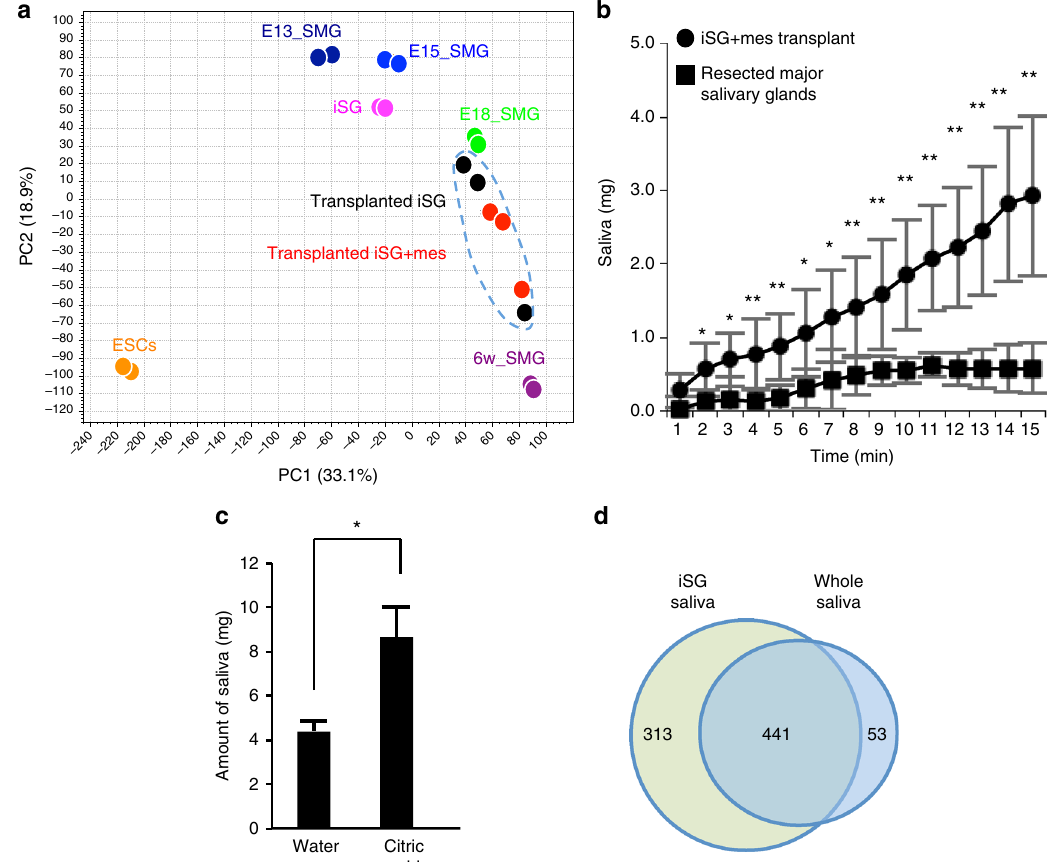
Fig. 5 Gene expression pro fi le and functional analysis of the transplanted iSG. a Principal component analysis based on RNA-seq. The data are shown for iSGs on d23, transplanted iSGs, transplanted iSG with mesenchyme, ESCs, SMG at E13.5, E15.5, E18.5, and 6 weeks. The blue circle outline indicates transplanted iSGs with or without mesenchyme. b Time-course of the amount of saliva secretion in major salivary glands-defective mice (square) and combined iSG transplanted major salivary glands-defective mice (circle), every 1 min for 15 min after intraperitoneal injection of pilocarpine; n = 8 mice (iSG-transplanted); n = 4 mice (major salivary gland defect). * P < 0.05, ** P < 0.001. c Assessment of the amount of saliva secretion in combined iSG- transplanted major salivary glands-defective mice for 8 min after water or gustatory (citric acid) stimulation; n = 4 mice (each group). * P = 0.034. d Venn diagram illustrating the proteins between iSG-derived saliva and whole saliva. n = 3 mice (each group). The results are presented as the mean ± S.D. Statistical analyses were performed using Student ’ s t